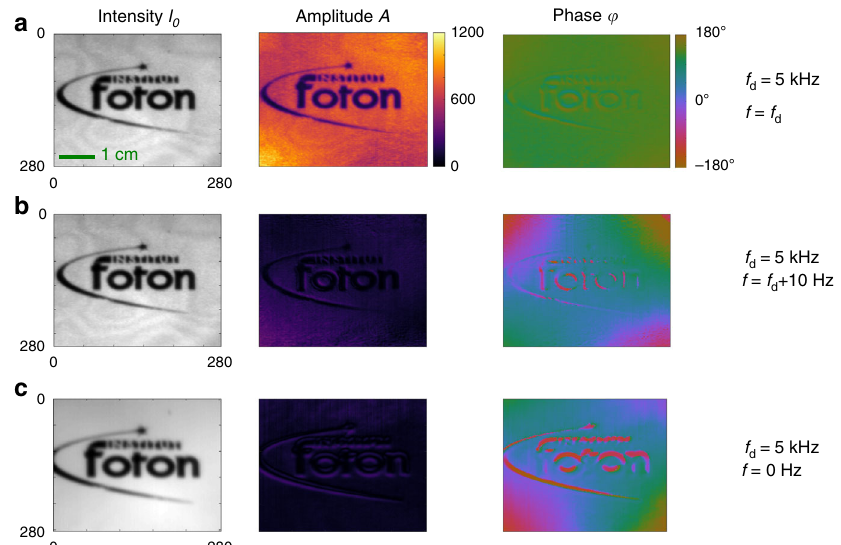
Fig. 2 Demonstration of snapshot image demodulation with FAST-QUAD. In this grid of images, the left column contains the mean (DC) intensity of the source (the logo of Institut FOTON), the central column contains the amplitude map and the right column the phase map obtained by demodulation at frequency f d by FAST-QUAD. a The fi rst row corresponds to the case where the scene is uniformly illuminated with laser light modulated at f ¼ f resulting in strong demodulated amplitude signal and uniform phase map. b The second row corresponds to the source being modulated at f ¼ f resulting in almost null demodulated amplitude. c The third row corresponds to the case where the source is unmodulated, hence allowing to mimic illumination by spurious ambient light. In this case, the demodulated amplitude is negligible